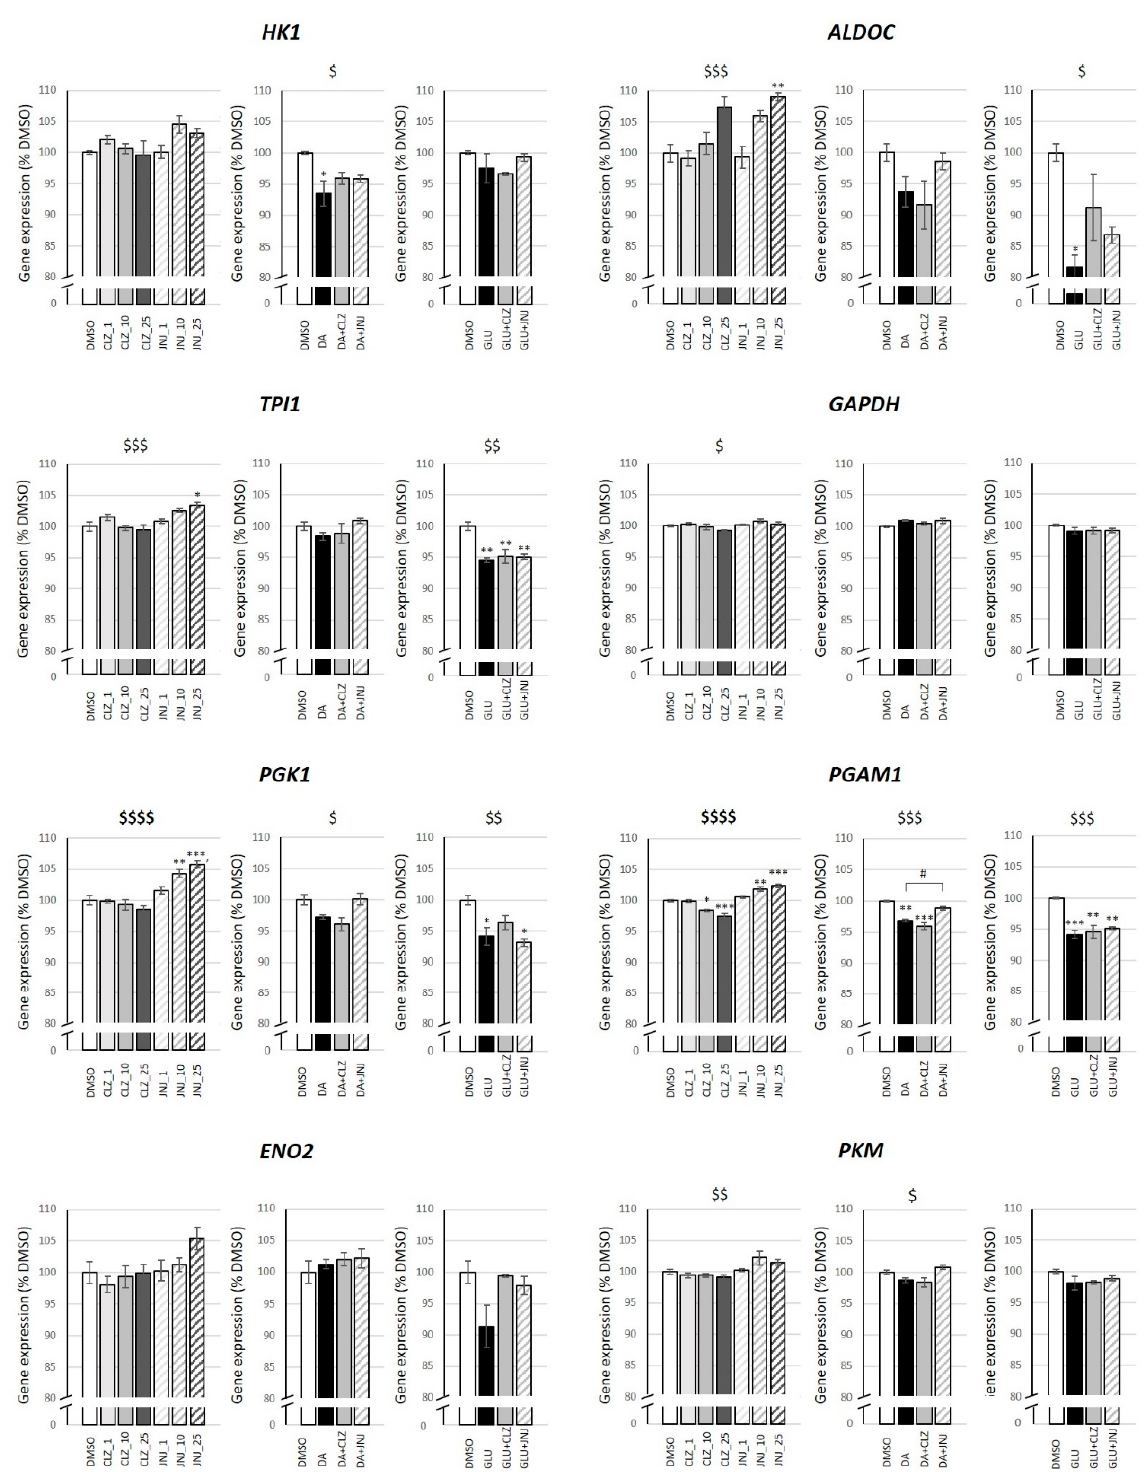
Figure 5. Effects of different concentrations of clozapine (CLZ) and JNJ-46356479 (JNJ) alone and in combination with dopamine (DA) at 100 µM or in combination glutamate (GLU) at 80 mM on the expression levels of glycolytic genes. Values represent percentages of the control (DMSO-treated cells) and are expressed as means ± S.E.M (n = 3). Two-way ANOVA was performed to assess the drug treatment and concentration effect on cells treated with CLZ (1, 10 and 25 µM) or JNJ (1, 10 and 25 µM) alone. One-way ANOVA was performed to assess the drug treatment effect on cells exposed to DA or GLU alone or in combination with CLZ (10 µM) or JNJ (10 µM). Significant asso- ciations for ANOVAs are shown as $ p ≤ 0.05, $$ p ≤ 0.01, $$$ p ≤ 0.001 and $$$$ p < 7.3 × 10 − 5 (Bonferroni corrected value: 0.05/226 genes × 3 experimental conditions). Bonferroni’s post hoc test was used for pair comparisons. * p ≤ 0.05, ** p ≤ 0.01, *** p ≤ 0.001 vs. control; # p ≤ 0.05 vs. DA. ADCY5 , adenylate